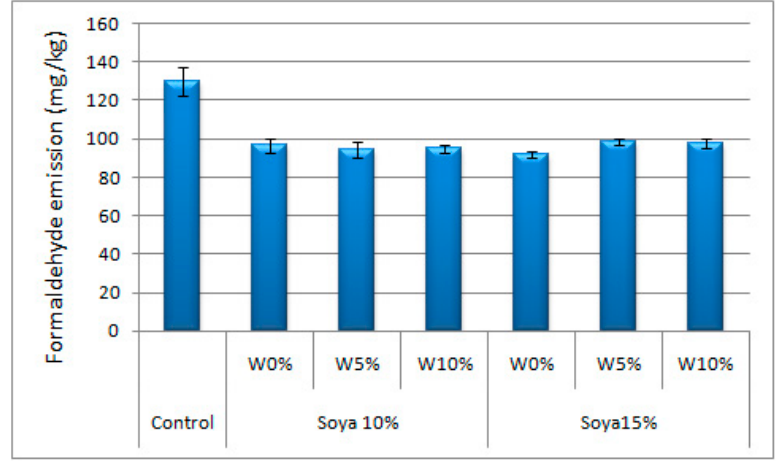
Figure 7. Formaldehyde emission (mg/kg) in three-layer plywood panels (Soy% = soy flour content; W% = wollastonite content).